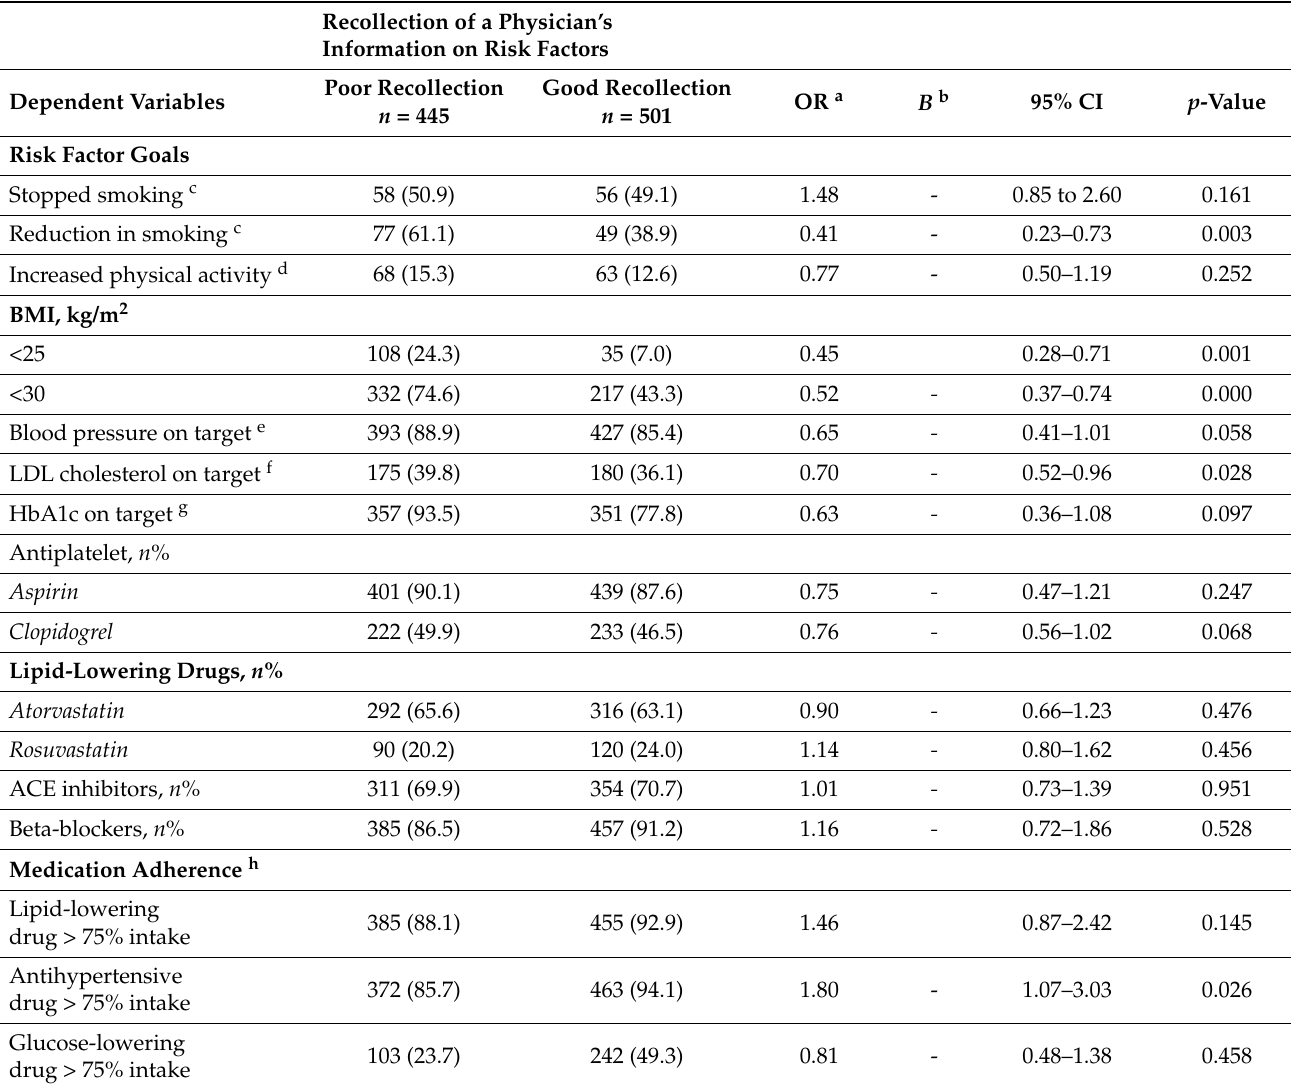
Table 2. Determinants of Recollection of a Physician’s Information on Risk Factors in Chronic Coronary Syndrome